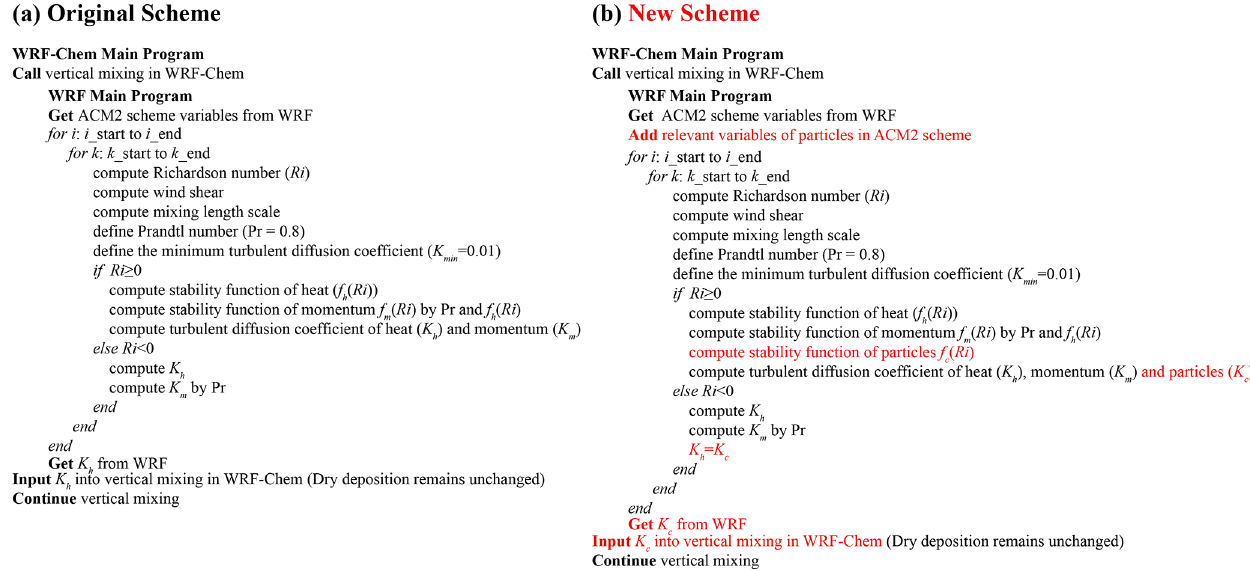
Figure 2. Flow chart of main program for turbulent diffusion coefficient in the (a) original scheme and (b) new scheme.